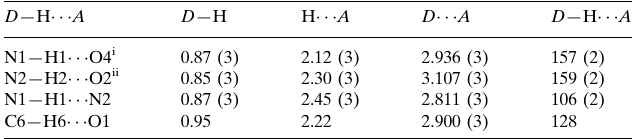
Hydrogen-bond geometry (A˚ , (cid:1)